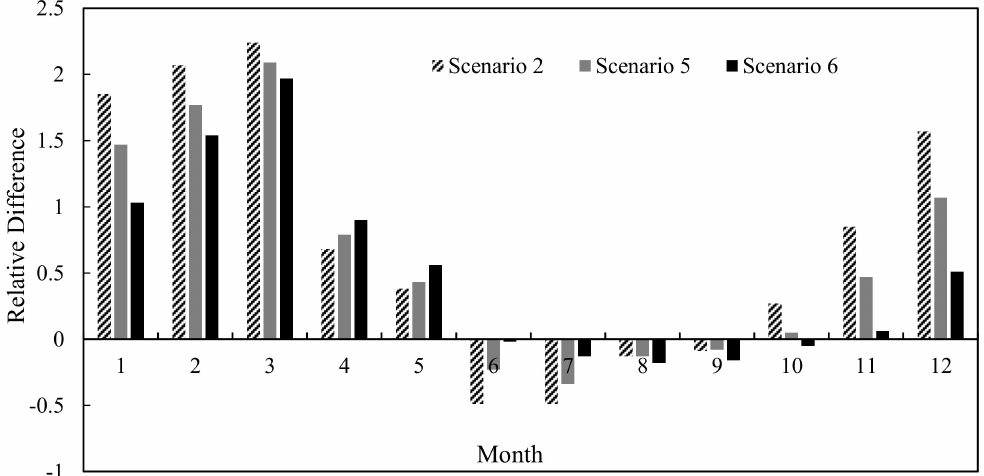
Figure 6. The impact of the reservoir location on the monthly average flow (over multiple years) (Scenarios 1–2 and